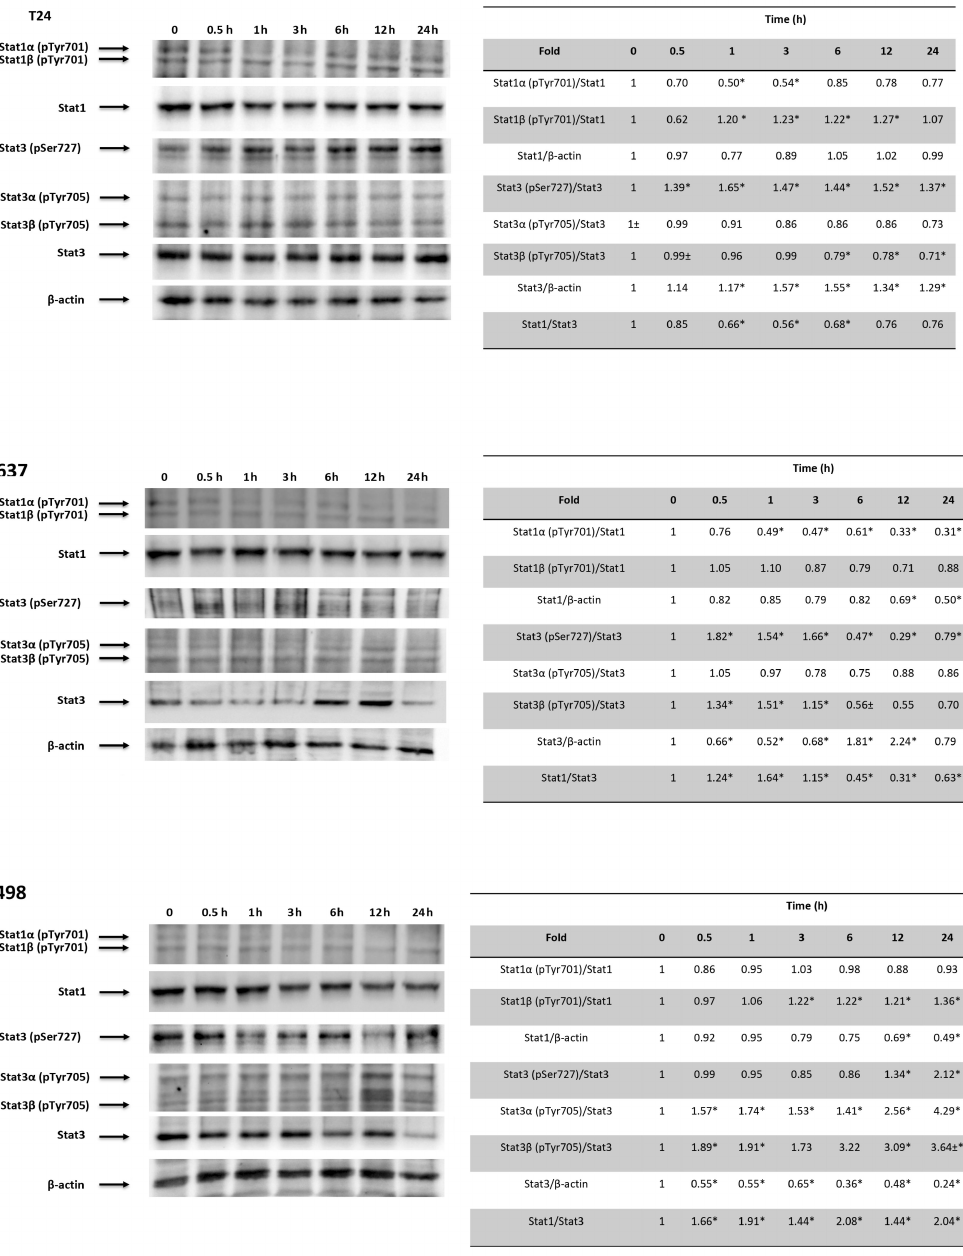
Figure 8. CPS effects on Stat1 and Stat3 activation. Western blot analysis of Stat1, Stat1 α (pTyr701), Stat1 β (pTyr701), pStat3 (pSer727), Stat3 α (pTyr705), Stat3 β (pTyr705) and Stat3 protein expression in T24, 5637 and A498 cell lines treated with 50 µ M CPS for 12 and 24 h. Blots are representative of one of three separate experiments. Stat1 α (pTyr701) and Stat1 β (pTyr701) densitometry values were normalized to Stat1. Stat3 (pSer727), Stat3 α (pTyr705) and Stat3 β (pTyr705) densitometry values were normalized to Stat3. Stat1 and Stat3 densitometry values were normalized to β -actin, used as the loading control. Stat1 and Stat3 protein levels of treated cells were determined with respect to their levels in untreated cells. No differences were observed between untreated cells and vehicle-treated cells. Data are representative of three different experiments; * p < 0.01. Detailed information about the Western blotting can be found in Figure